Question: Generate an informative caption for the figure above.
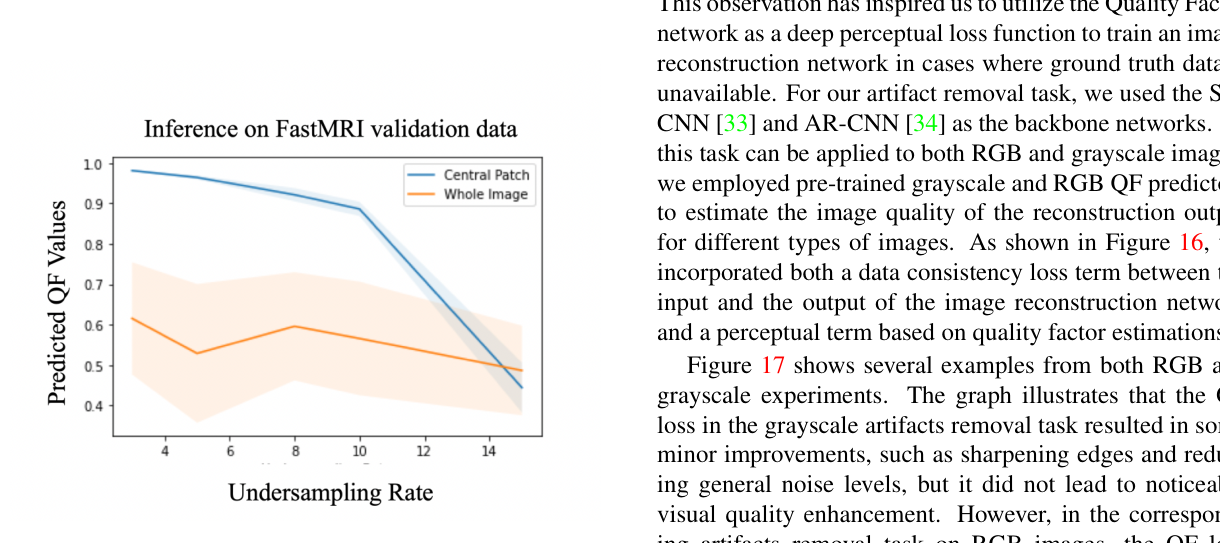
Answer: Correlation curves between the under-sampling rate and the QF prediction from the pre-trained network.